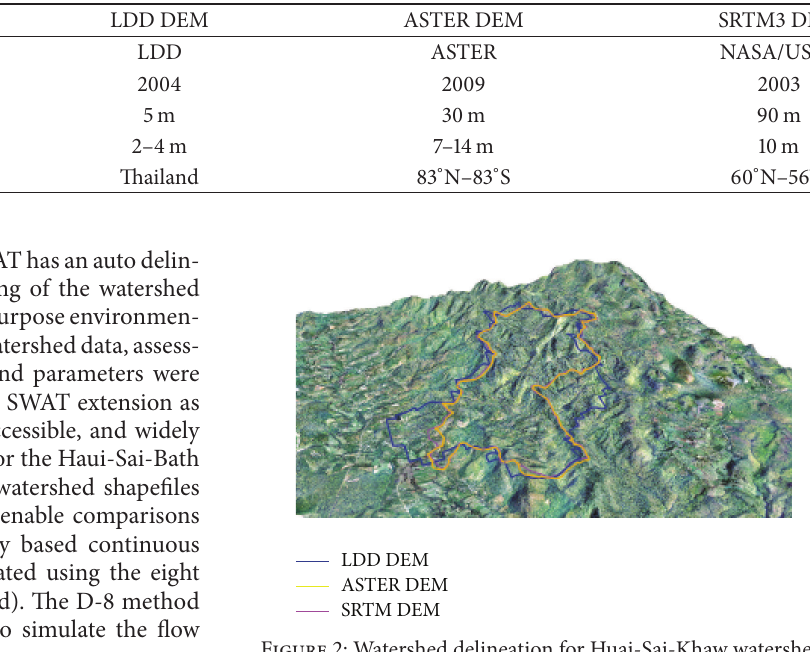
Table 1: Detail of DEM sourses.